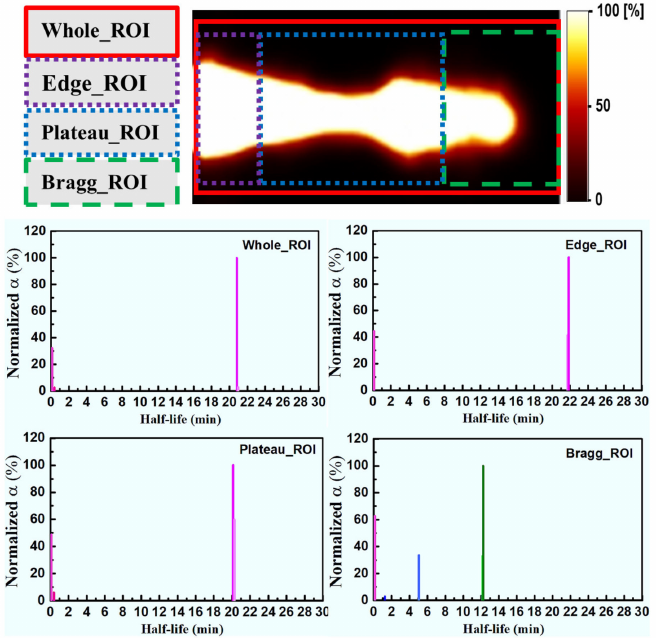
Figure 7. The spectral analysis (SA) for different ROIs. Pink shows no radioisotope components, magenta shows 11 C, blue shows 15 O and green shows 13 N radioisotopes,